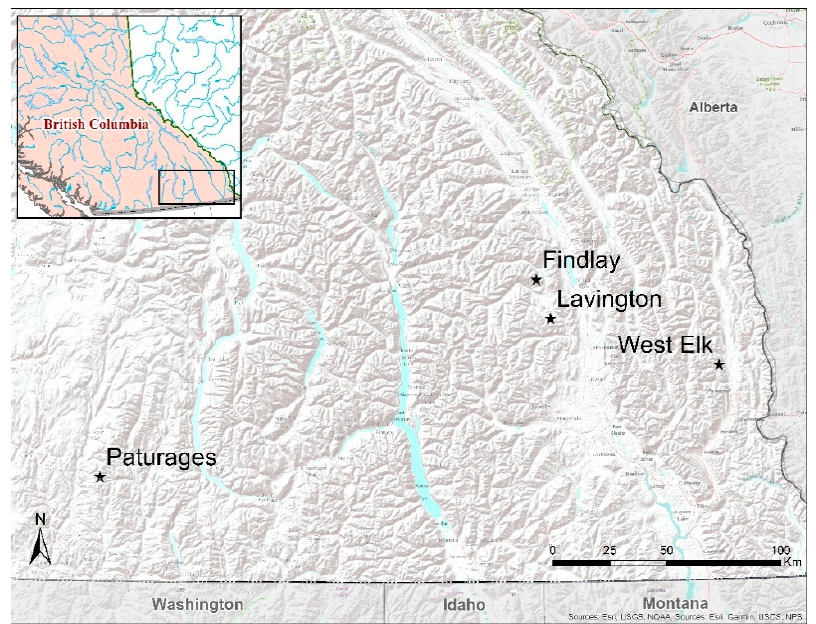
Figure 1. Harvest sites in southeastern British Columbia. Findlay consists of two separate but adjoining harvests units. Table 1. Summary of five sampled harvest sites in southeastern British Columbia.